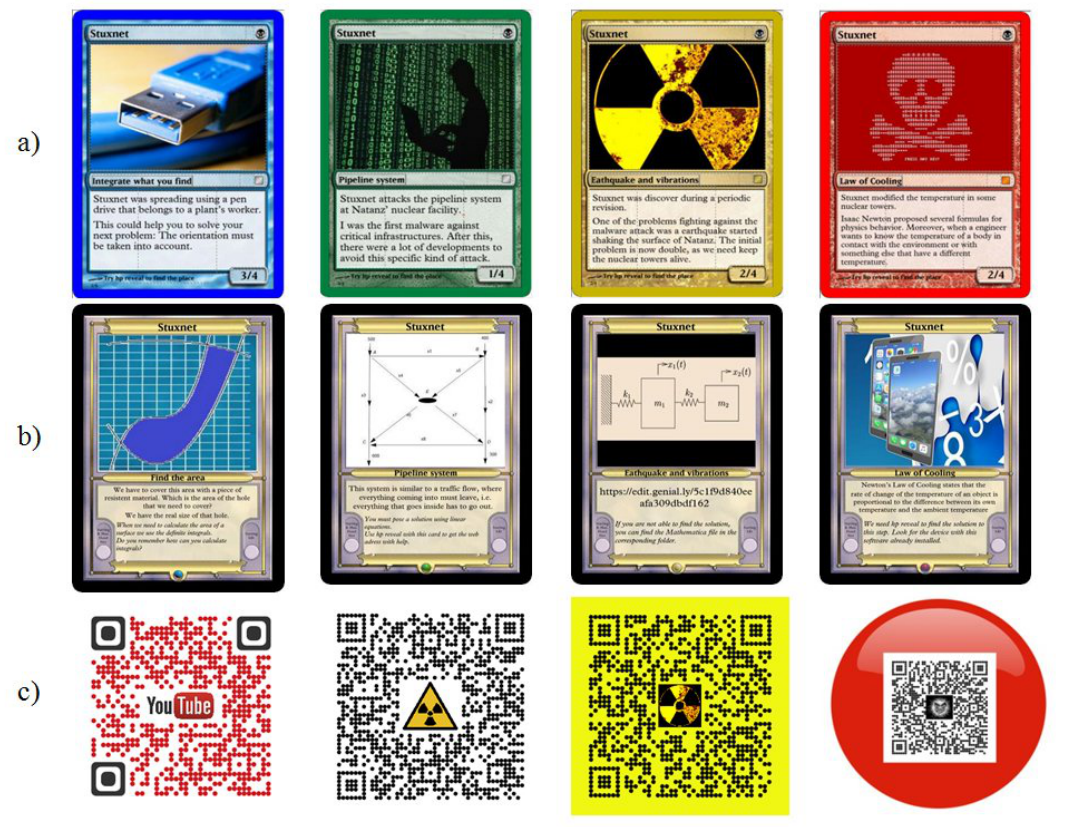
Figure 7. ( a ) Teams’ Stuxnet cards; ( b ) Clue cards when using HP Reveal over ( a ); ( c ) Final result when using HP Reveal over ( b